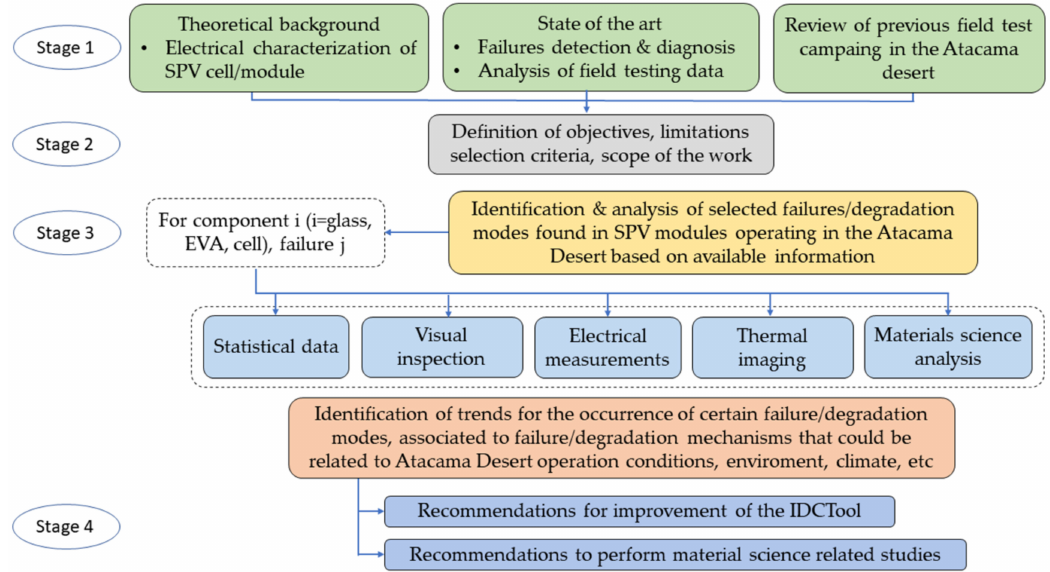
Figure 3. Methodological strategy for the elaboration of the